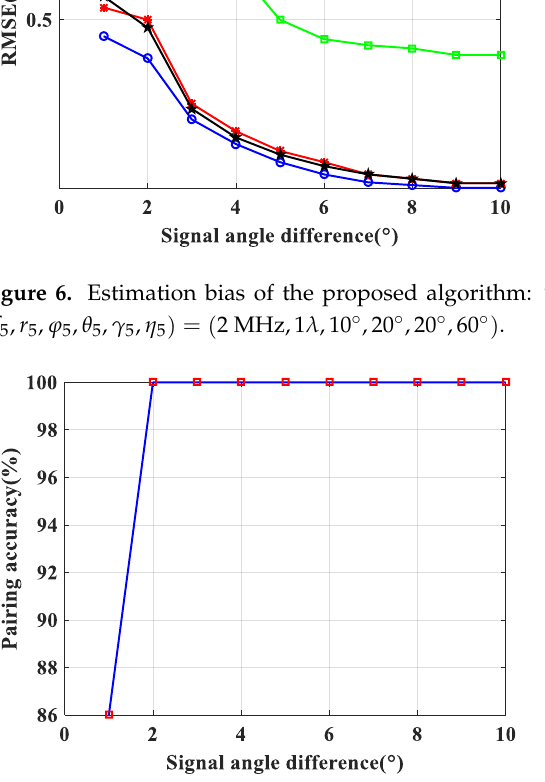
Figure 7. The pair matching accuracy of the proposed algorithm: SNR = 20 dB, snapshot